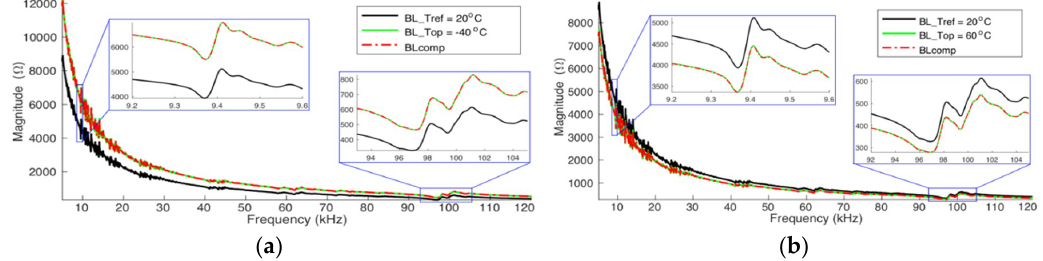
Figure 17. Complete compensation—Case 3 (Simulation) pipe-1/PZT-1: ( a ) from +20 °C to −40 °C and ( b ) from +20 °C to +60 °C.